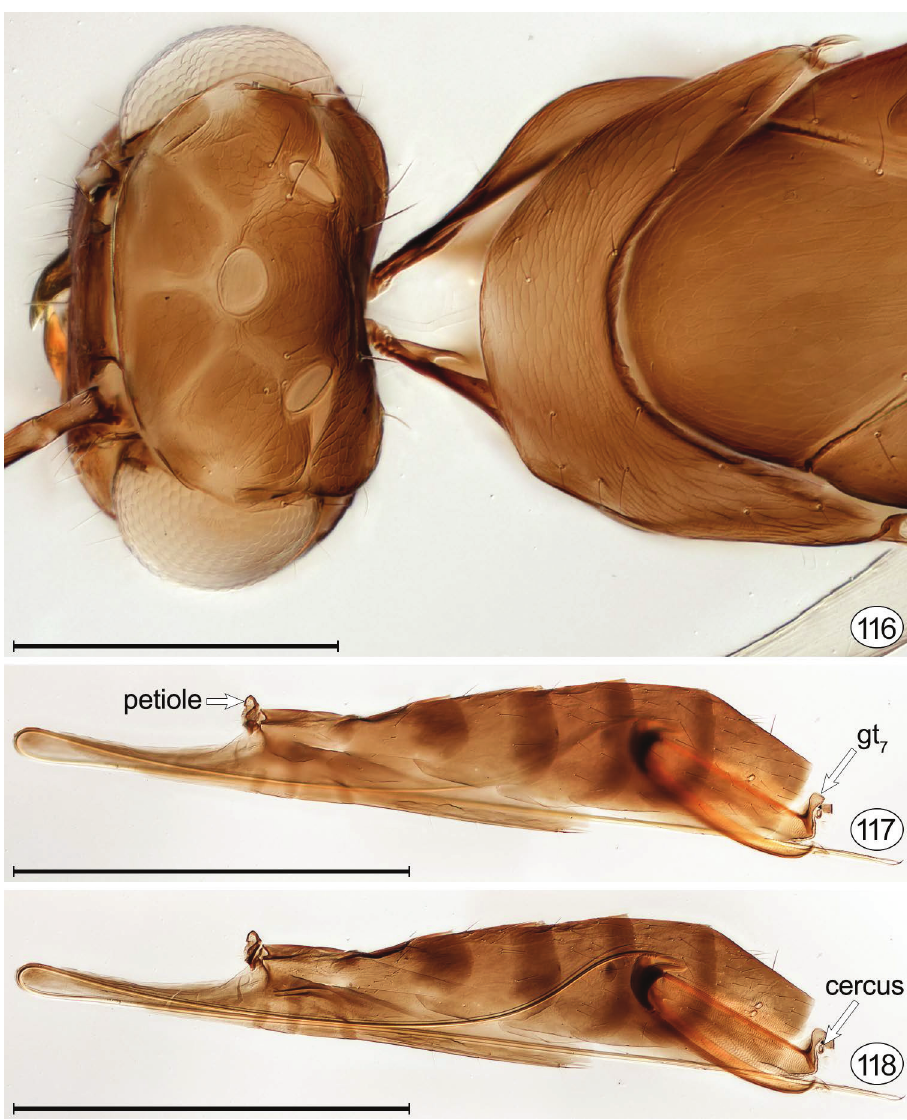
Figures 116–118. Neotriadomerus longiovipositor , female paratypes. 116 head + anterior of mesoso- ma, dorsal (near Swamp Mitchell Plateau Airfield) 116 metasoma, lateral (18.5 km W. Gordonvale) 117 metasoma, median plane 118 metasoma, lateral. Scale bar for 116 = 200 μm; 117, 118 = 1000 μm. Description. Female . Body length ≈ 1700–2250 (n=6). Colour. Body (before slide mounting one specimen) uniformly shiny black except mouthparts brown; an- tenna dark brown but scape and pedicel ventrally slightly lighter; pro- and mesocoxa dark brown except extreme apices yellowish, metacoxa dorsally almost black; the rest of each leg yellowish except for femur ventrally of fore- and mid leg, entire femur